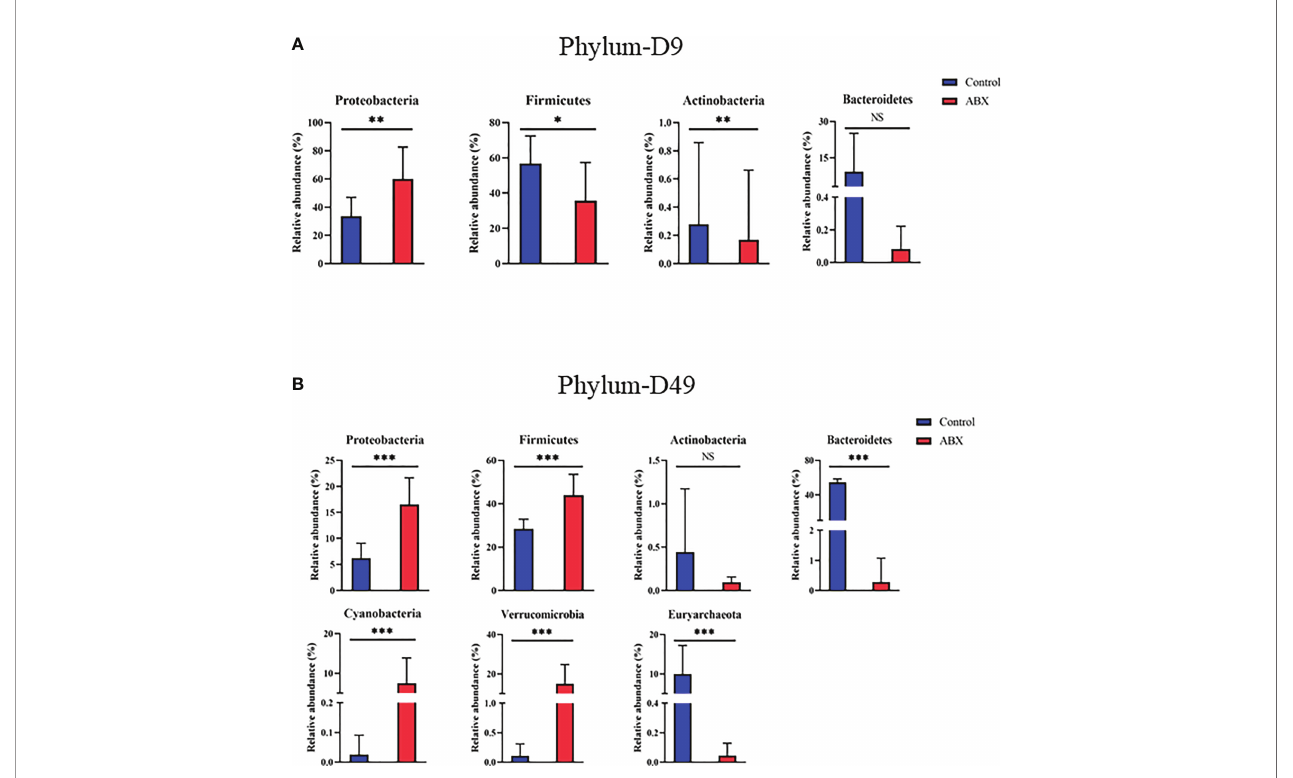
FIGURE 5 | Relative abundance of the gut microbiota at the phylum level showing signi fi cant changes in response to antibiotic treatment during early life. (A) Differences in relative abundance of phyla between the controls (Ctr) and antibiotic treatment (ABX) on day 9. (B) Differences in relative abundance of genera between Ctr and ABX on day 49. * p < 0.05, ** p < 0.01, *** p < 0.001; Wilcoxon rank-sum test. n ≥ 8 for each group. ns, not signi fi